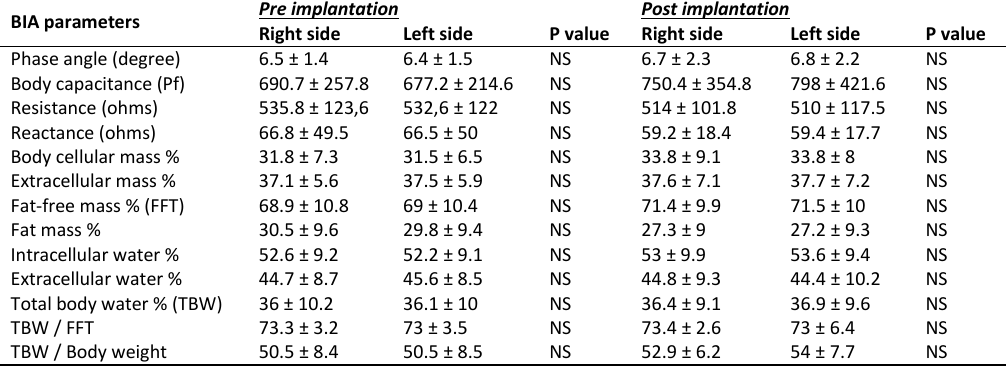
Table 3: Comparison of bioimpedance parameters before and after cardiac device implantation on both sides Right side Left side BIA parameters Pre implantation Post implantation P value Pre implantation Post implantation P value Phase angle (degree)